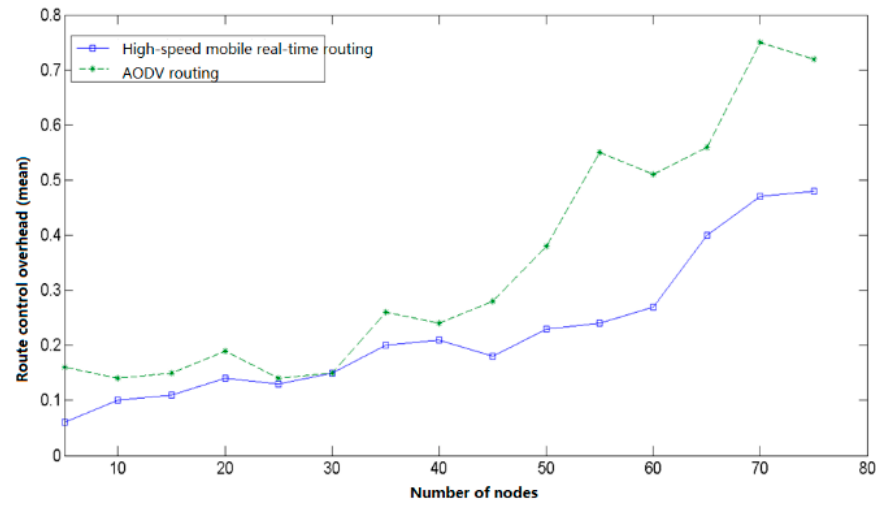
Figure 15. Routing Control Overhead.